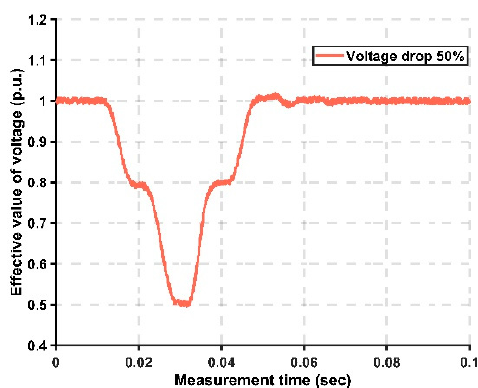
Figure 6. Measured voltage drop’s 50% curve.